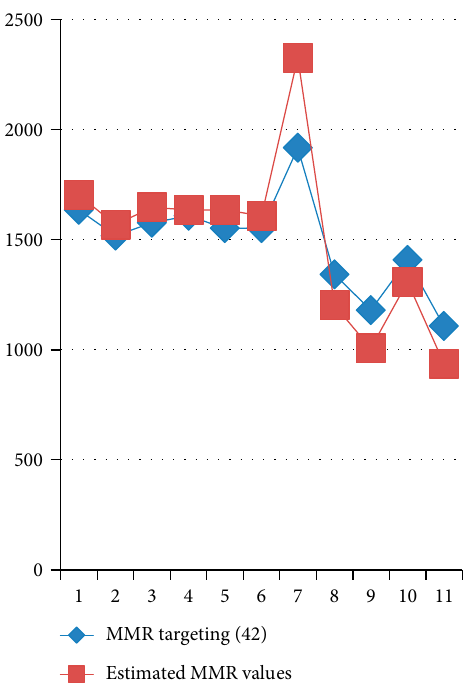
Figure 5: Actual and estimated values of one-third of MMR, using reduced Poisson regression model given in Equation